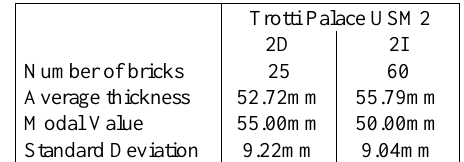
Table 4. Data evaluation from the USM2 of Trotti Palace.